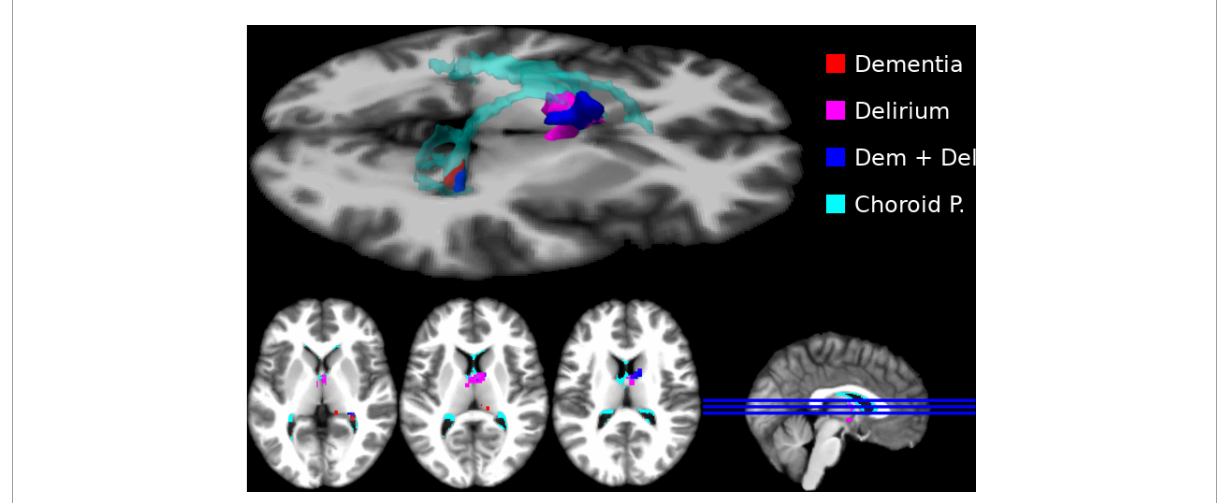
FIGURE1 Subcortical regions where the cognitively healthy (CH) sample presented higher distribution volume ratio (DVR). Here we show significant subcortical differences (thresholded at p < 0.05 FEW corrected) in DVR intensity per group (CH > Delirium–magenta; CH > Dementia–red; CH > Delirium + Dementia–blue). We show an overlap between the regions that presented significant DVR differences and choroid plexus (cyan). No other effects for experimental groups were significant.